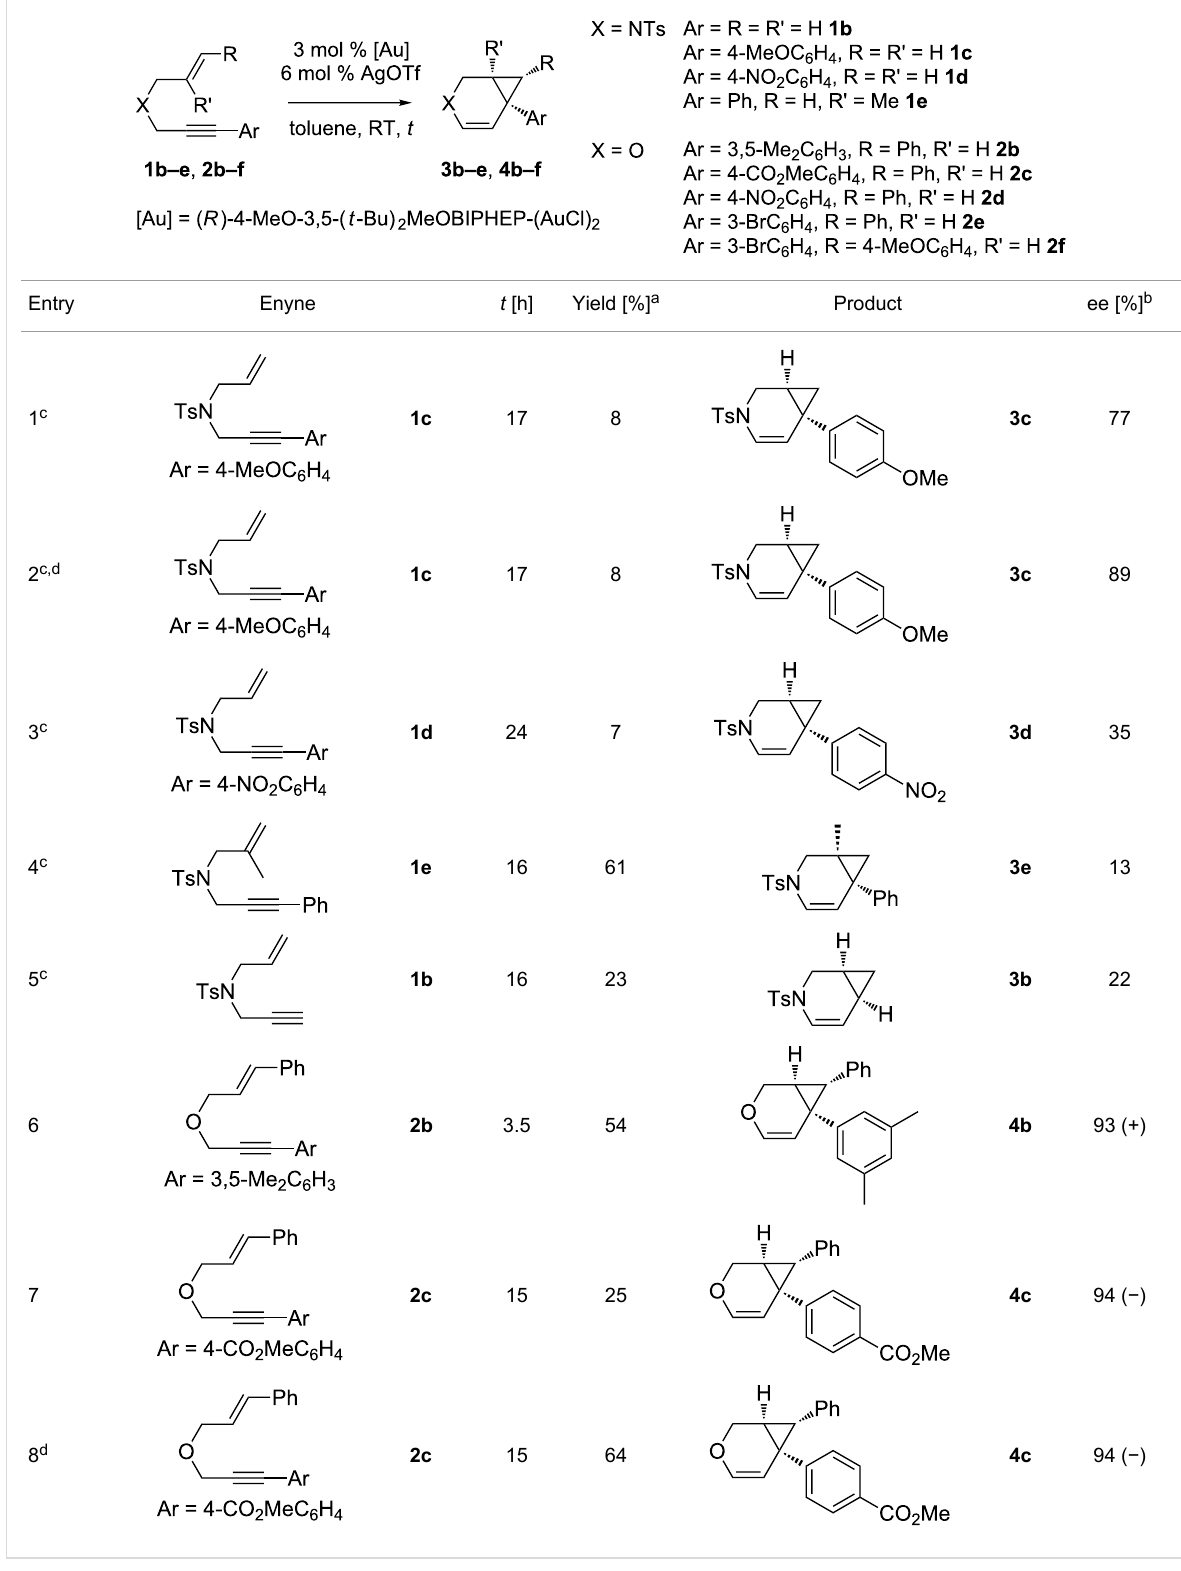
Table 2: Cycloisomerization reaction of nitrogen- and oxygen-linked